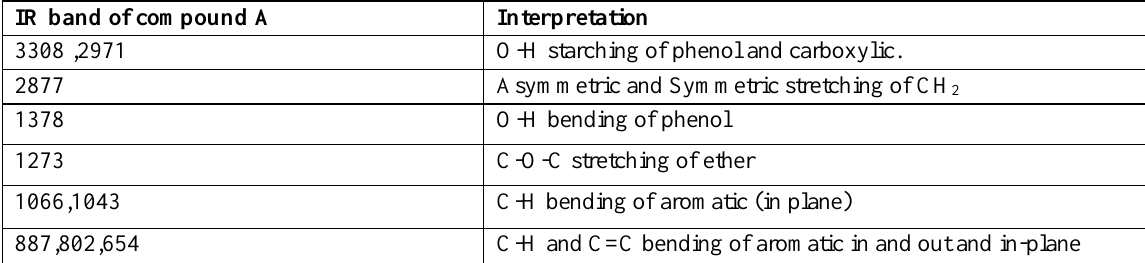
Figure 7. IR spectrum for compound A Table 1 .The FTIR spectrum regions indicated the major functional groups in compound A IR band of compound